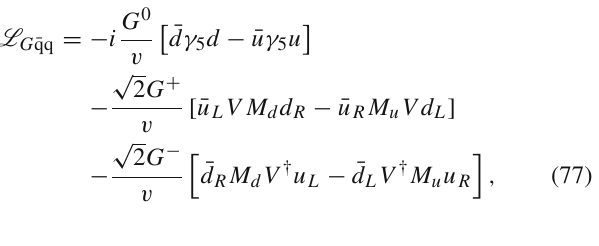
( a ) M Min vs. tan β . (b) M Max vs. tan β .